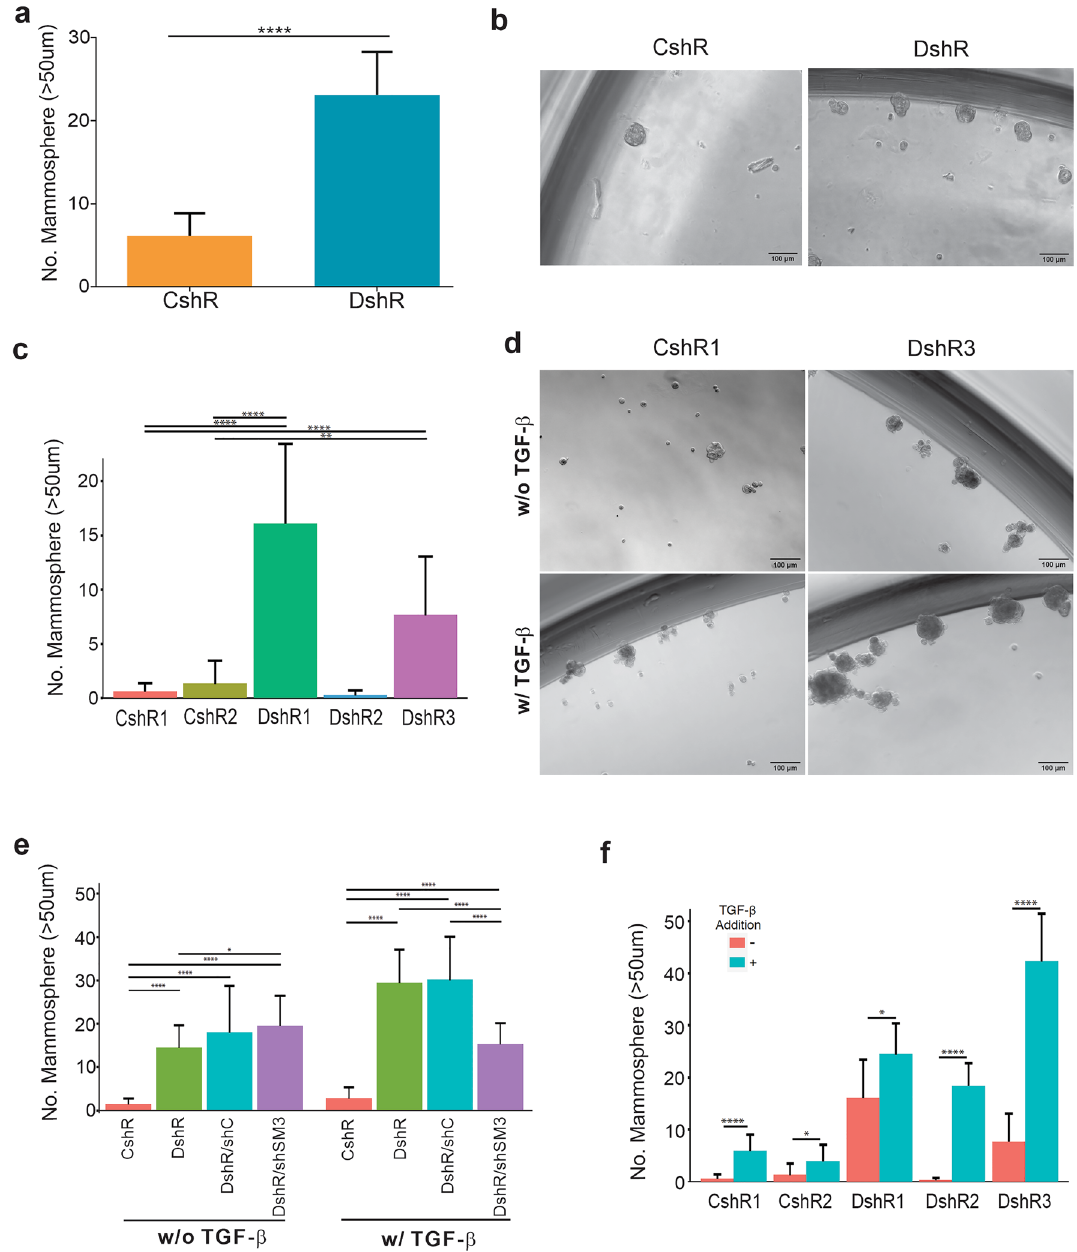
Figure 1. Stable DEAR1 -KD in HMECs results in increased numbers of mammosphere independent of SMAD3 expression. ( a ) Representative bar plots showing mean ± SD counts of primary mammospheres (> 50um) from control vector (CshR) and DEAR1 -KD (DshR) MCF10A cells across three trials. Each cell line was grown in at least 8 wells of 96-well plate in mammosphere growing conditions for 17 days for each individual trial. P-values were calculated using a two-tailed Student t-test between groups. **** p < 0.0001. ( b ) Representative images of mammospheres from ( a ) taken using a Zeiss microscope at ×10 magnification (Scale bars equal 100 µm). ( c ) Bar graphs representing the mean ± SD number of mammospheres (> 50 µm) formed from two control vector clones (CshR) and three DEAR1- KD clones (DshR) from 76N-E6 cells grown in mammosphere-growing conditions for 14 days across three trials. P-values were calculated using Wilcoxon Rank Sum tests. **p < 0.01 and ****p < 0.0001. ( d ) Representative images at ×10 magnification of CshR1 (left) and DshR3 (right) mammospheres quantified in panel ( c ) in the absence (top) and presence (bottom) of TGF-β (Scale bars equal 100 µm). ( e ) Bar plots showing the mean ± SD number of mammospheres formed from CshR, DshR, DshR/shC, and DshR/shSM3 cells without (left) and with (right) TGF-β treatment across 3 trials. p-values calculated using Wilcoxon Rank Sum tests. *p < 0.05–0.1 and ****p < 0.0001. ( f ) Bar graphs represent the mean ± SD number of mammospheres (> 50 µm) formed from two control vector clones (CshR) and three DEAR1- KD clones (DshR) from 76N-E6 cells treated with TGF-β and grown in mammosphere growing conditions for 14 days across three trials. P-values were calculated using Wilcoxon Rank Sum tests. *p < 0.05–0.1 and ****p < 0.0001. The barplots in ( c ), ( e ) and ( f ) were created using RStudio (Version 1.0.143), https:// www. rstud io.